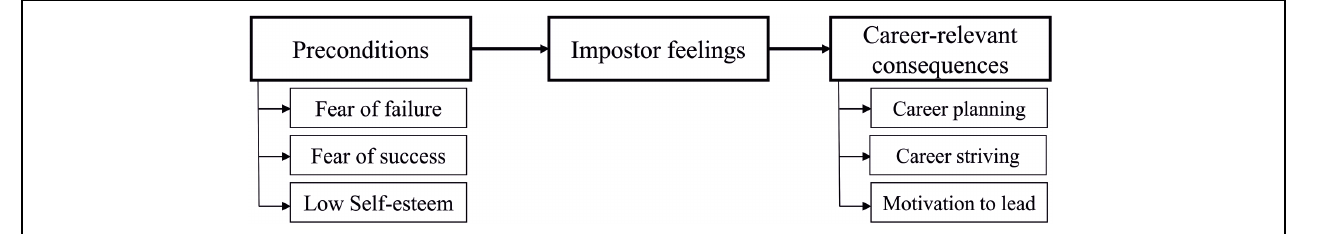
FIGURE 1 | Hypothesized model of preconditions for and career-relevant consequences of impostor